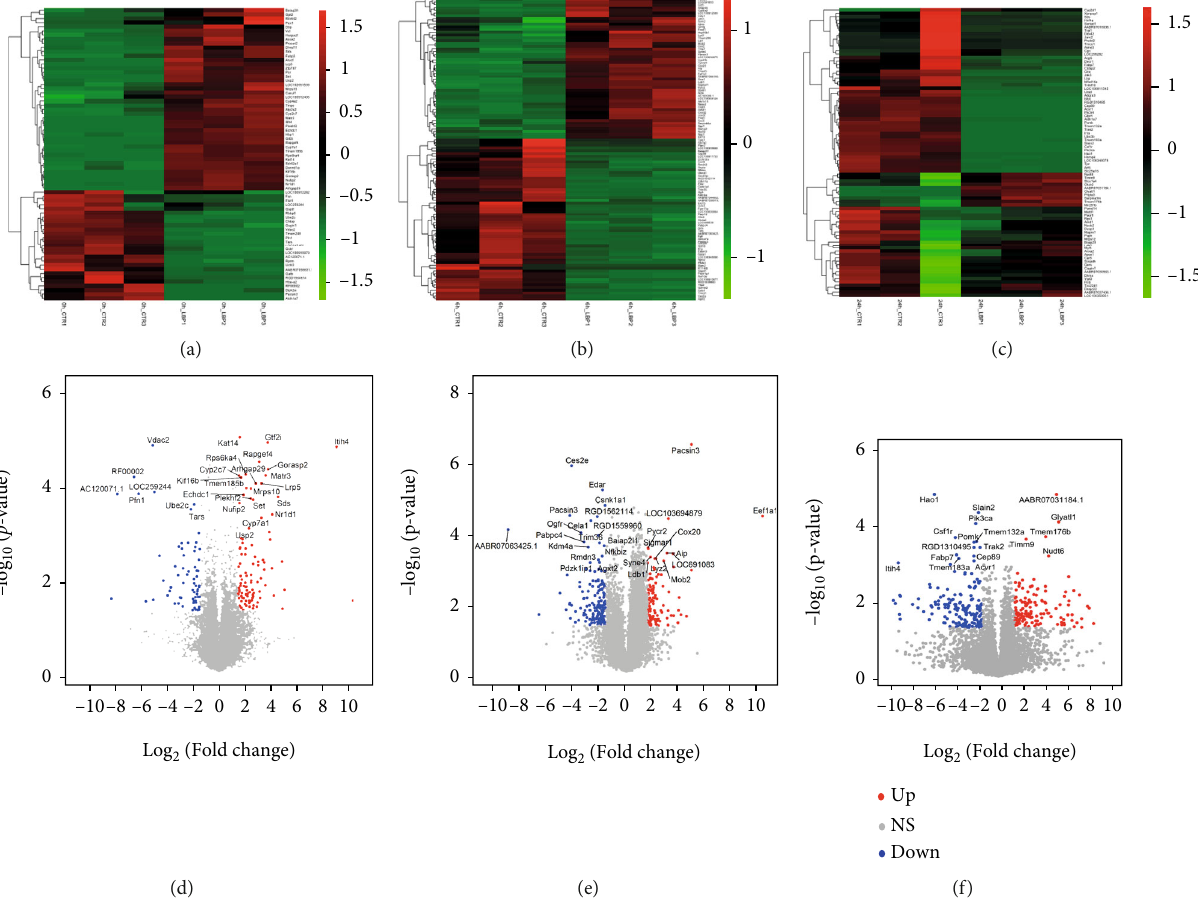
Figure 2: Distinct transcriptional signature between WT and LBP-de fi cient rats. (a – c) Transcription pro fi les of signi fi cant di ff erentially expressed genes (DEGs) with log2(fold change) larger than 1.5 at P value < 0.01 at 0h, 6h, and 24 h, respectively. The labeling condition and DEGs were adapted as previous panels. (d – f) The volcano plot of LPS-induced transcriptional changes between normal and LBP-de fi cient rats with the time of 0 h, 6h, and 24h, respectively. Di ff erential expression genes with log2(fold change) larger than 1.5 at P value < 0.05 were colored with blue (downregulated) and red